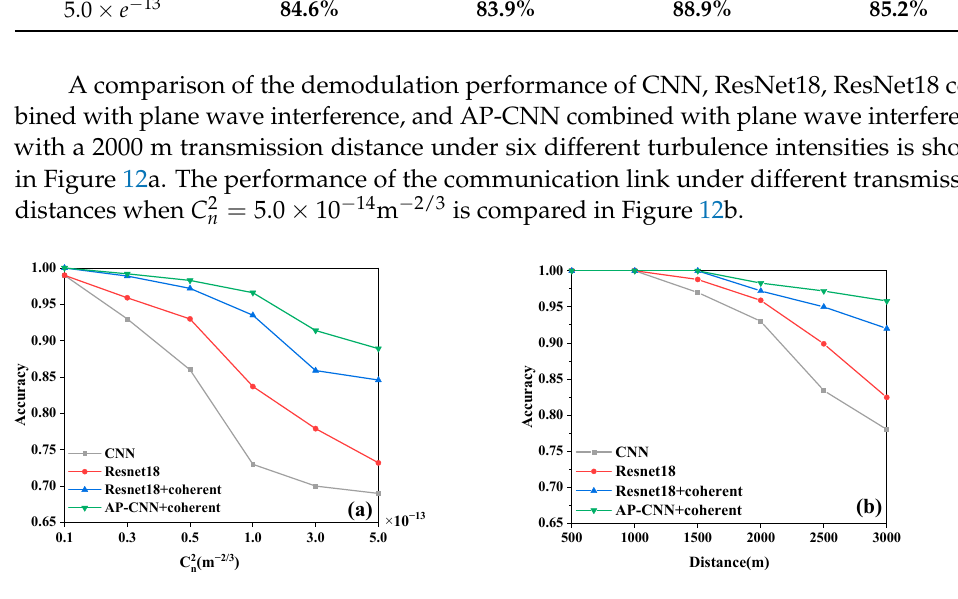
Figure 12. Performance of four OAM demodulators for detecting single-mode vortex light ( a ) under different turbulence intensities and ( b ) different transmission distances.